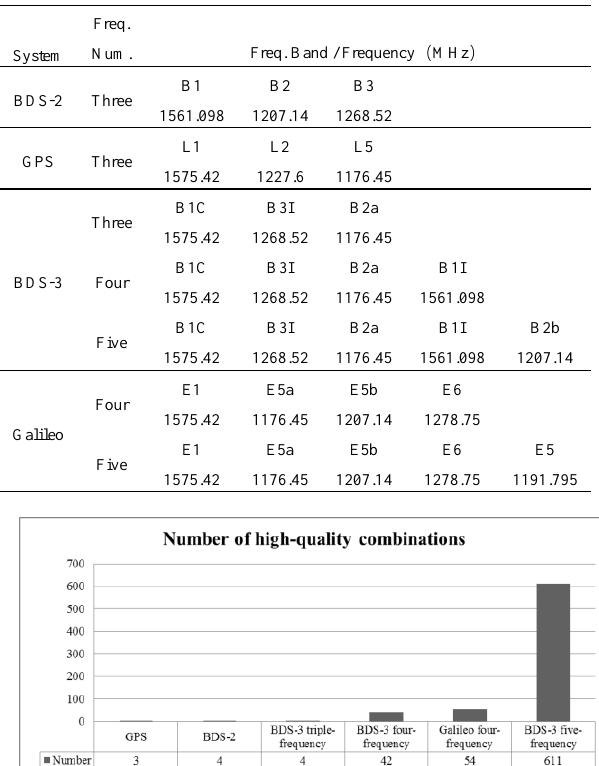
Figure 1. The statistical of multi-GNSS and multi-frequency high-quality extra-wide-lane